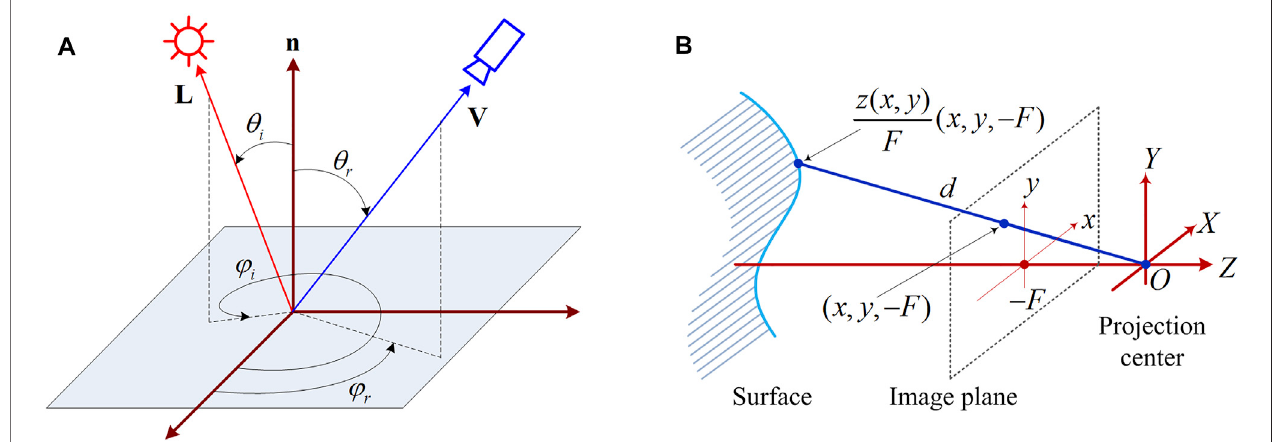
FIGURE 1 | Imaging model for perspective SFS. (A) Re fl ection geometry model of a surface and (B) Perspective projection model of a camera.